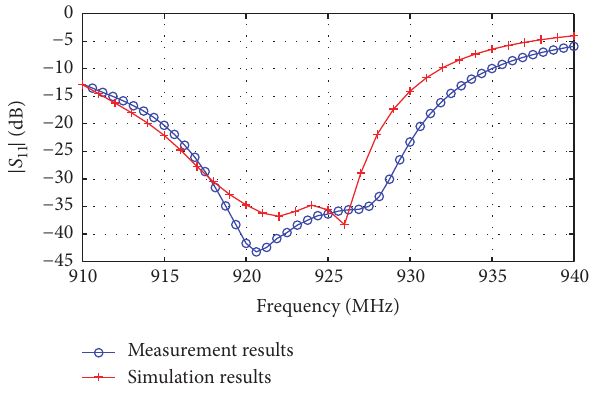
Figure 8: AR of the 4 × 4 SR antenna array.